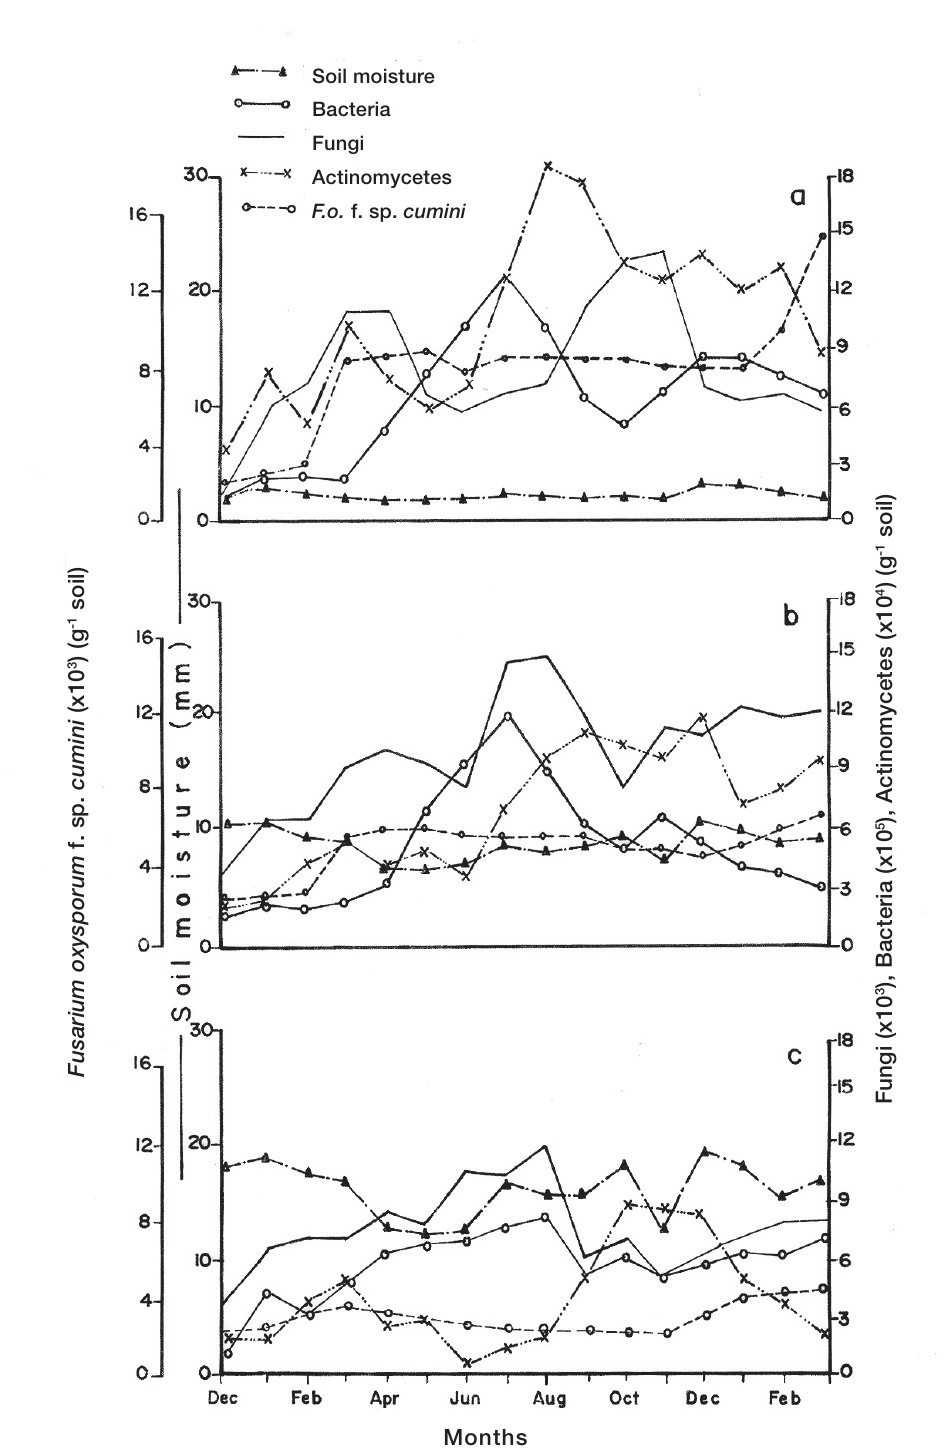
Fig. 2. Mean monthly levels of soil moisture, and presence of Fusarium oxysporum f. sp. cumini, and other micro- bial populations at different soil depths, in fields planted with cumin (a) at 0–5 cm soil depth; (b) at 6–15 cm, and (c) at 16–25